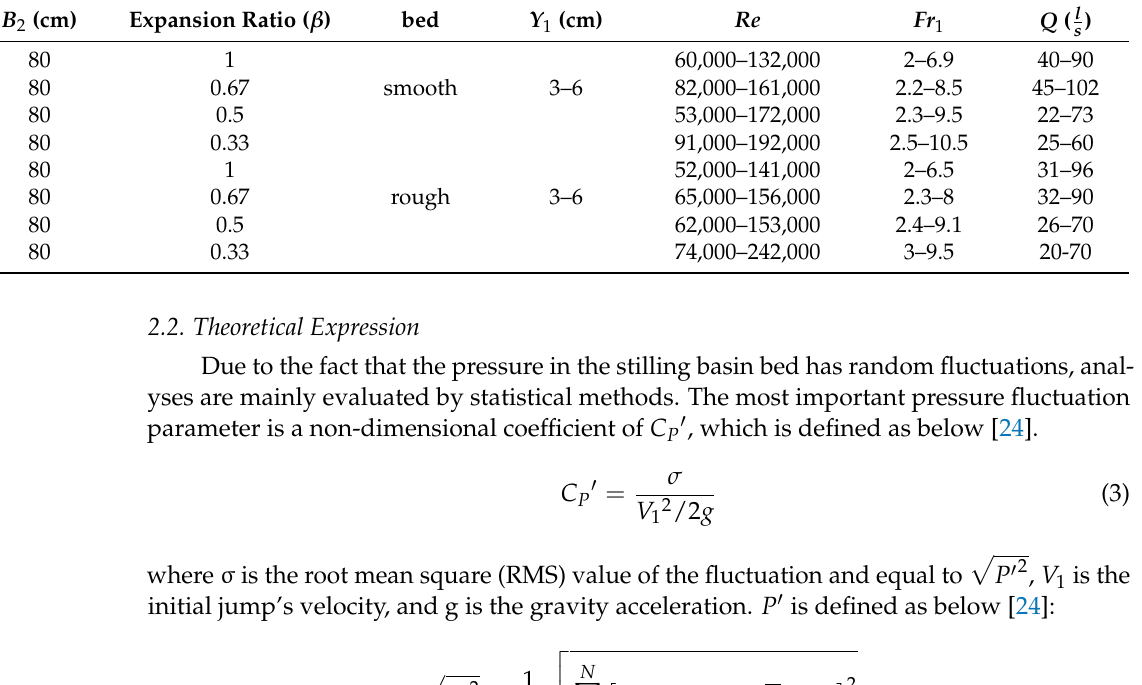
Figure 3. Pressure transducers and display of output results. Table 1. Ranges of measured